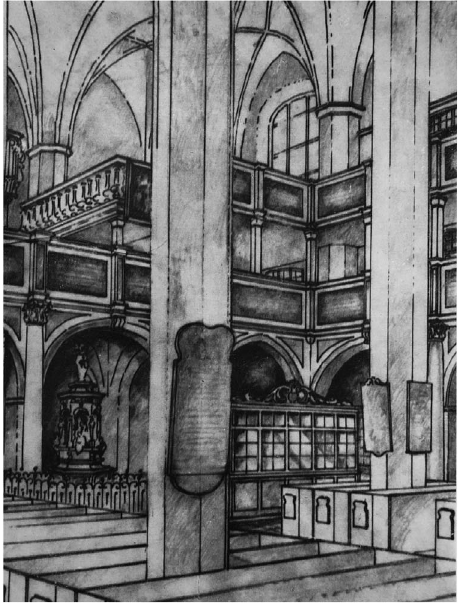
Figure 2. Drawing of Thomaskirche ’ s double gallery in Bach ’ s era [47].